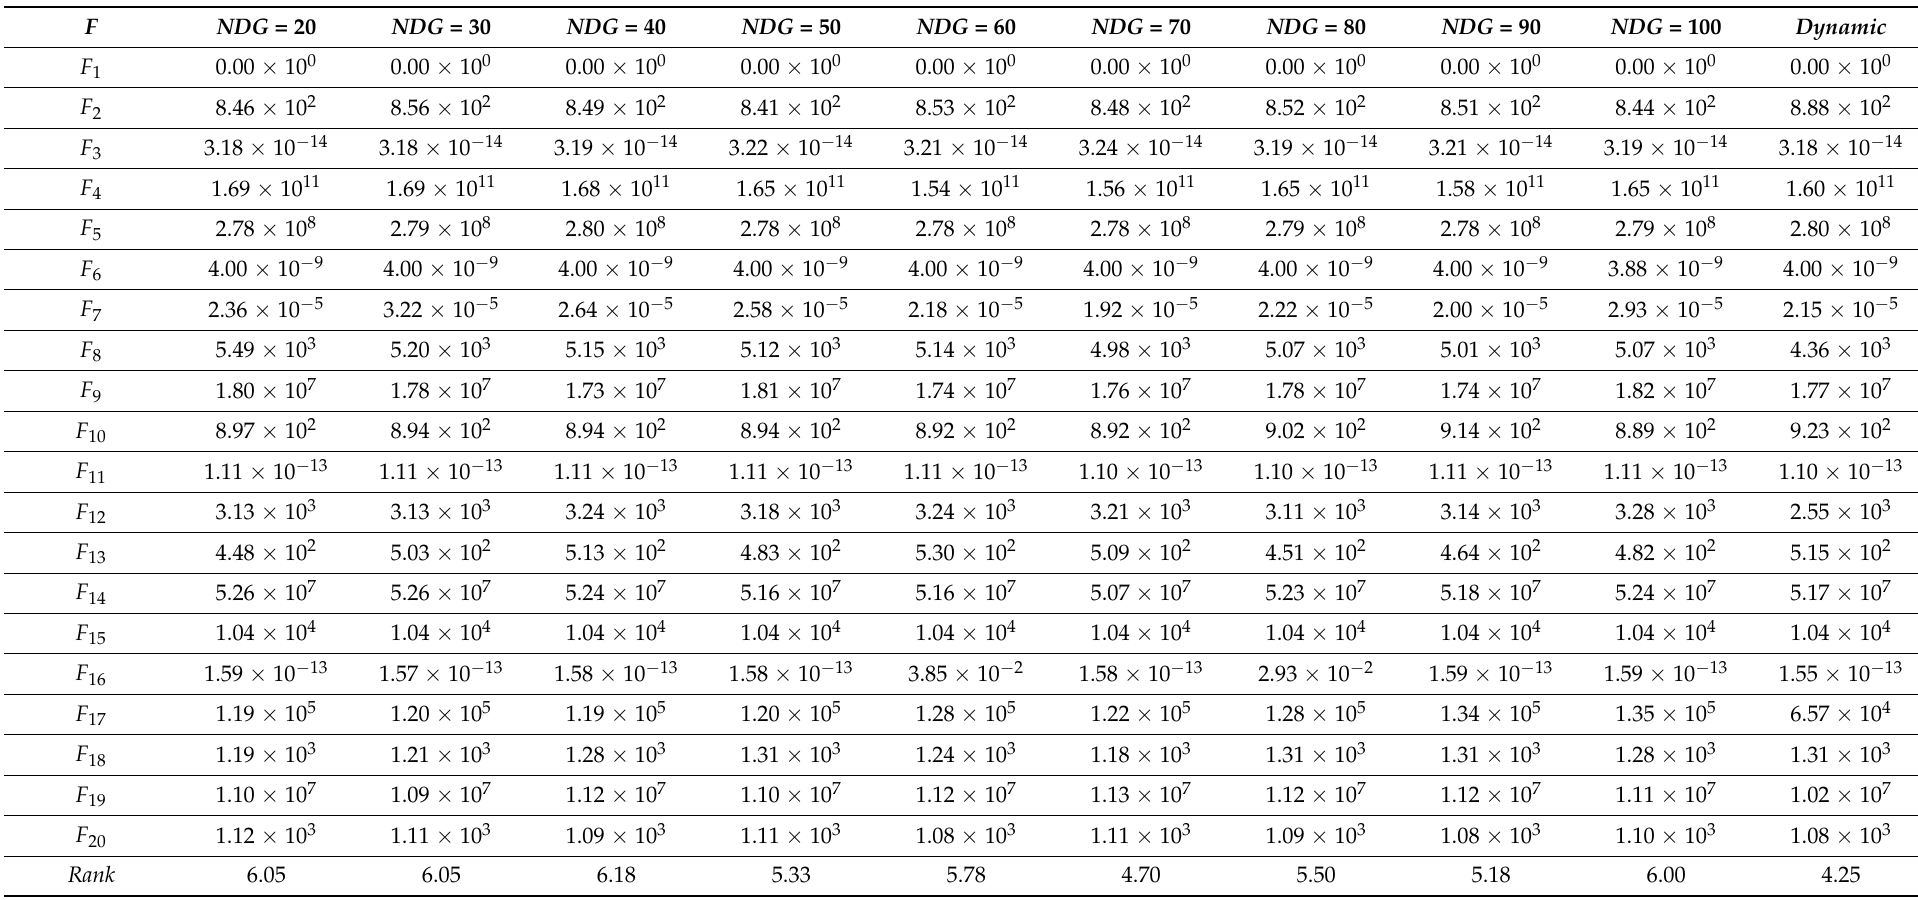
Table 7. Comparison results between DGCELSO with the dynamic strategy for NDG and the ones with different fixed settings of NDG on the 1000-D CEC’2010